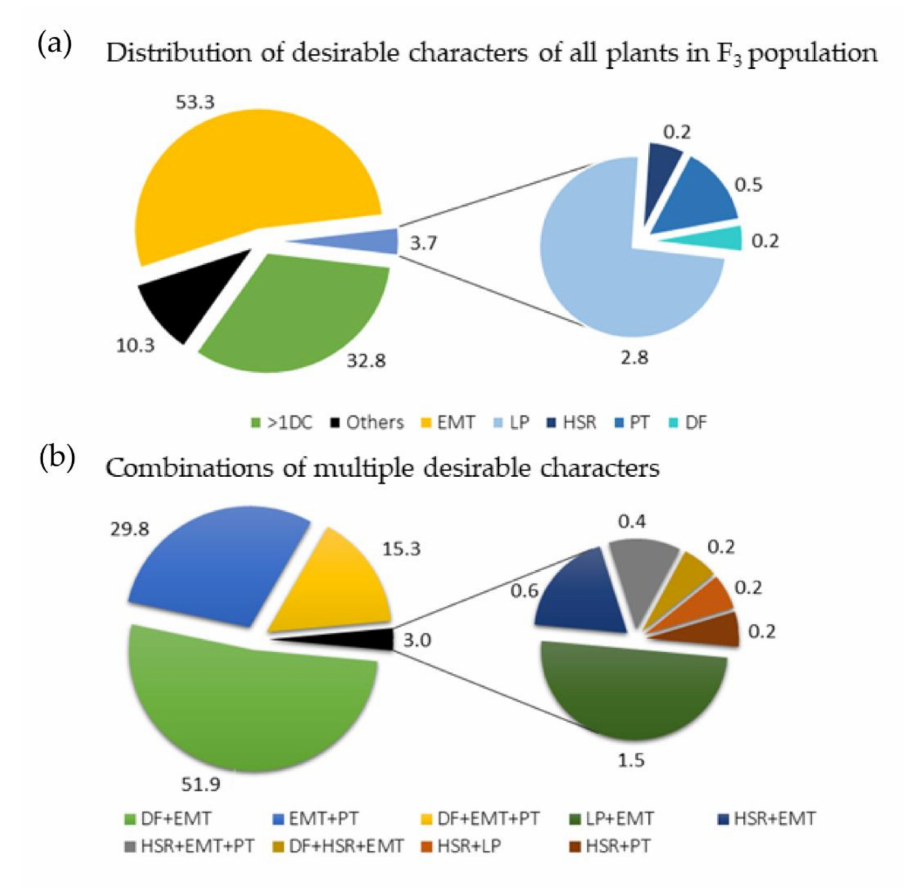
Figure 1. A total of 1656 F 3 plants were analyzed for the five characteristics: flowering habit, pod shattering resistance, seed yield per plant, earliness, and perenniality. ( a ) Pie charts showing the percentage of plants having no, one, or more than one desirable characters of the five characteristics among the 1656 F 3 plants. ( b ) Pie charts showing the percentage of plants, showing di ff erent combinations of desirable characters for the five characteristics among 543 plants (32.8% of the 1656 plants analyzed), showing more than one desirable characteristic. > 1DC = have more than one desirable characteristic; early maturing type (EMT); large plants (LPs); highly shatter-resistant (HSR); perennial type (PT); determinate flowering (DF); Others = lack desirable characters. Note: for plants having more than one desirable characteristic, “ + ” is used to show the combination; e.g., DF + EMT